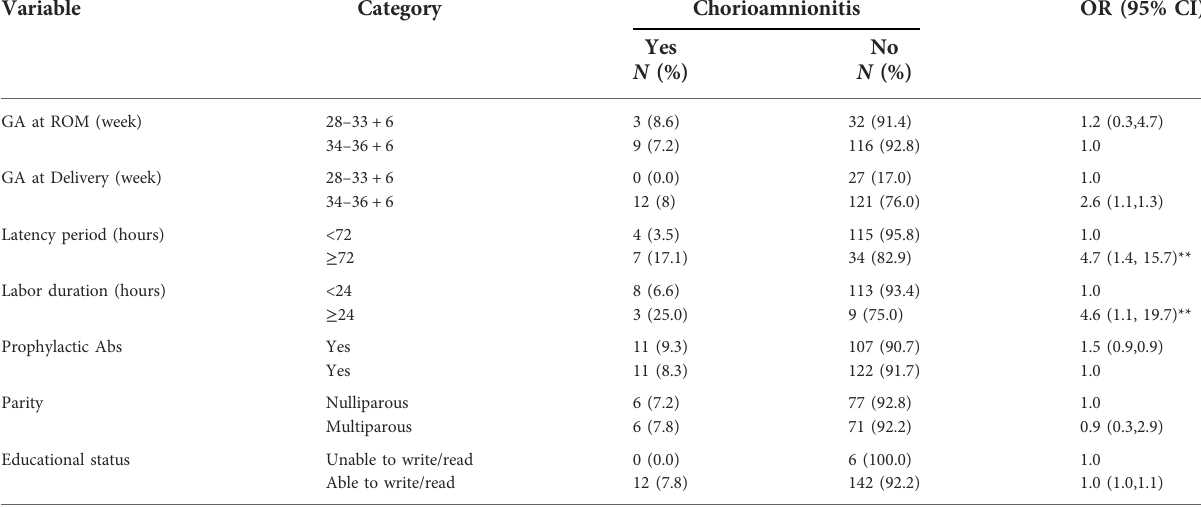
TABLE 7 Factors determining chorioamnionitis among pregnant women with preterm premature rupture of membrane.